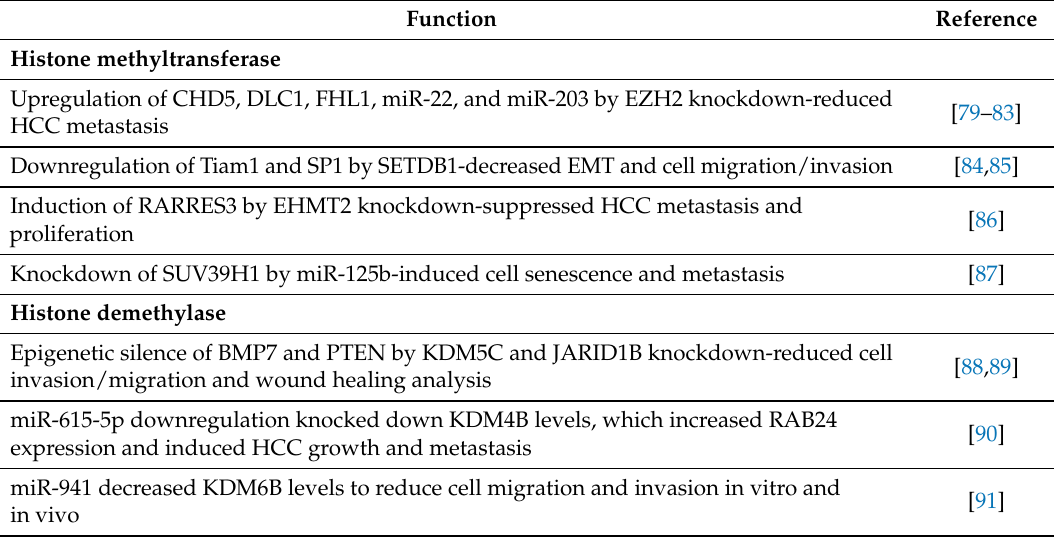
Table 3. Histone methyltransferase/demethylase in HCC